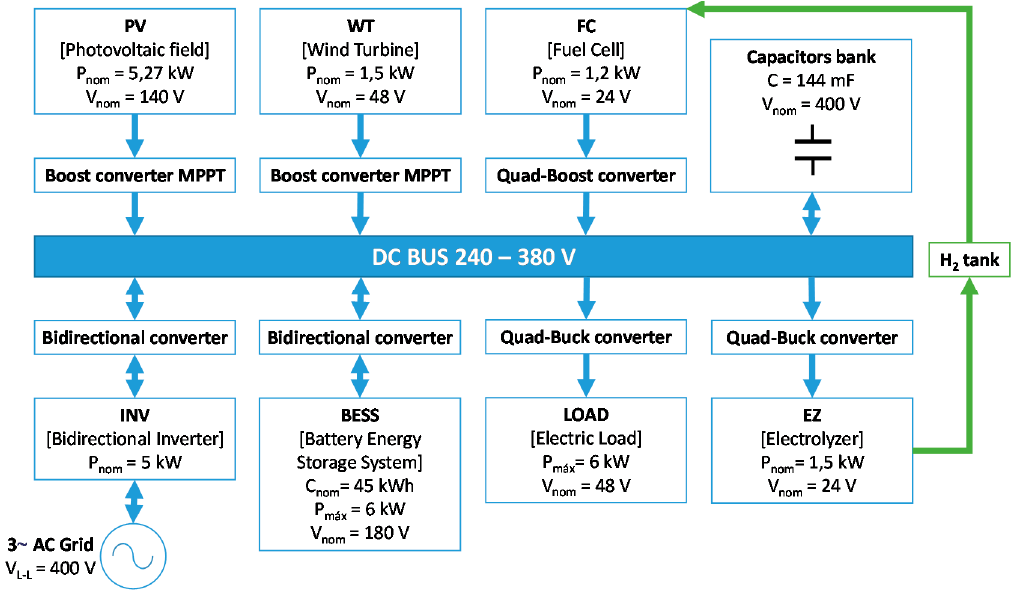
Figure 1. MG architecture. The MG is composed of a DC bus in which the following elements are connected: two Renewable Energy Sources (RES) (PV and WT), a controllable source (FC), a capacitors bank, a bidirectional grid-inverter (INV), a battery system (BESS), critical loads (LOAD), and a controllable load (EZ).